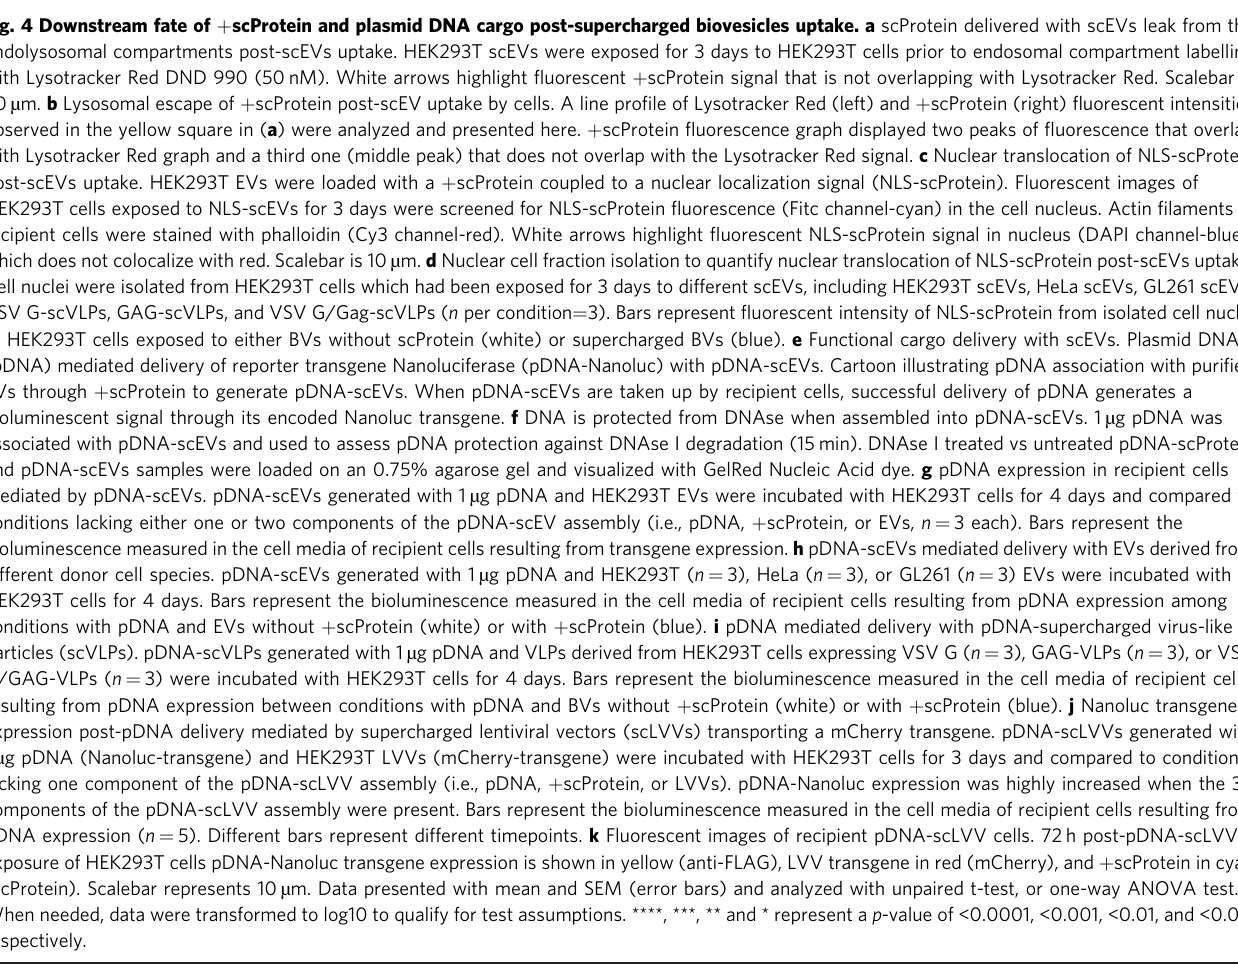
Fig. 4 Downstream fate of + scProtein and plasmid DNA cargo post-supercharged biovesicles uptake. a scProtein delivered with scEVs leak from the endolysosomal compartments post-scEVs uptake. HEK293T scEVs were exposed for 3 days to HEK293T cells prior to endosomal compartment labelling with Lysotracker Red DND 990 (50 nM). White arrows highlight fl uorescent + scProtein signal that is not overlapping with Lysotracker Red. Scalebar is 20 µ m. b Lysosomal escape of + scProtein post-scEV uptake by cells. A line pro fi le of Lysotracker Red (left) and + scProtein (right) fl uorescent intensities observed in the yellow square in ( a ) were analyzed and presented here. + scProtein fl uorescence graph displayed two peaks of fl uorescence that overlap with Lysotracker Red graph and a third one (middle peak) that does not overlap with the Lysotracker Red signal. c Nuclear translocation of NLS-scProtein post-scEVs uptake. HEK293T EVs were loaded with a + scProtein coupled to a nuclear localization signal (NLS-scProtein). Fluorescent images of HEK293T cells exposed to NLS-scEVs for 3 days were screened for NLS-scProtein fl uorescence (Fitc channel-cyan) in the cell nucleus. Actin fi laments in recipient cells were stained with phalloidin (Cy3 channel-red). White arrows highlight fl uorescent NLS-scProtein signal in nucleus (DAPI